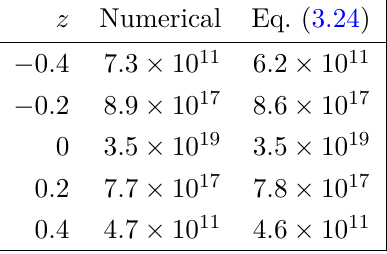
Table 1 . The ratio f k ( t = 100( qm φ ) − 1 ) /f k ( t = 10( qm φ ) − 1 ) , based on the numerical calculation (Numerical) and the approximation adopting the ansatz of the exponential increase (eq. (3.24)) with the growth rate given in eq. (3.29). We take q = 10 − 2 , and several values of ω as ω = 1 m φ (1 + zq ) k 2